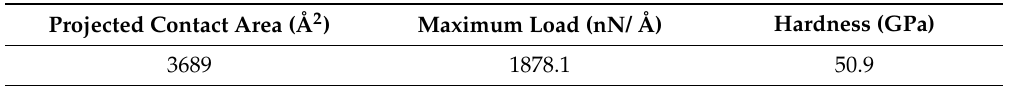
Table 1. Hardness and Young’s modulus calculated from nanoindentation. Calculated hardness on the nanoscale.